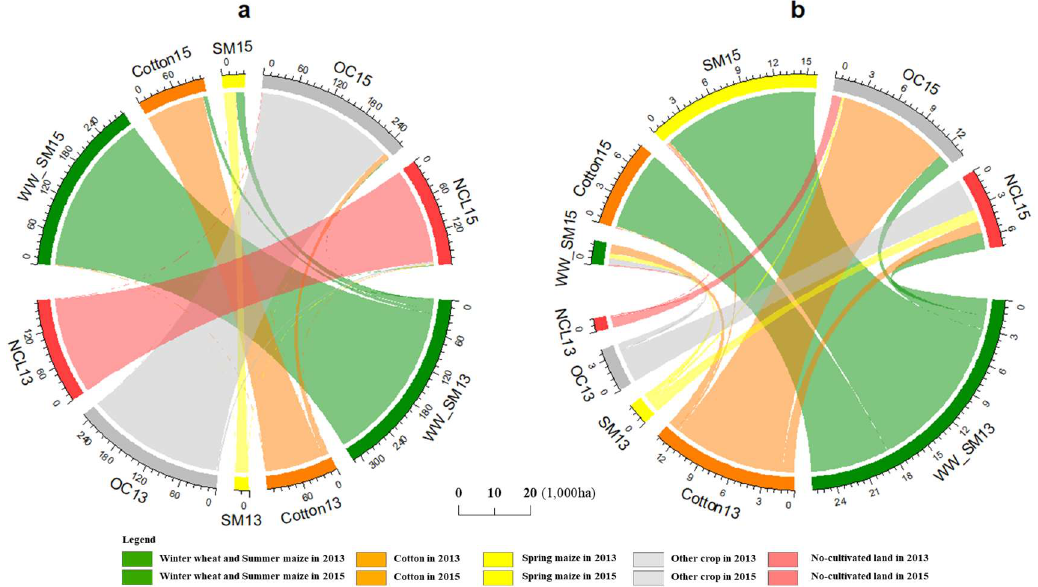
Figure 3. Land cover transfer chord diagram from 2013 to 2015 ( a ), and a land cover mutual transfer chord diagram after the same land cover transfer was excluded from 2013 to 2015 ( b ).